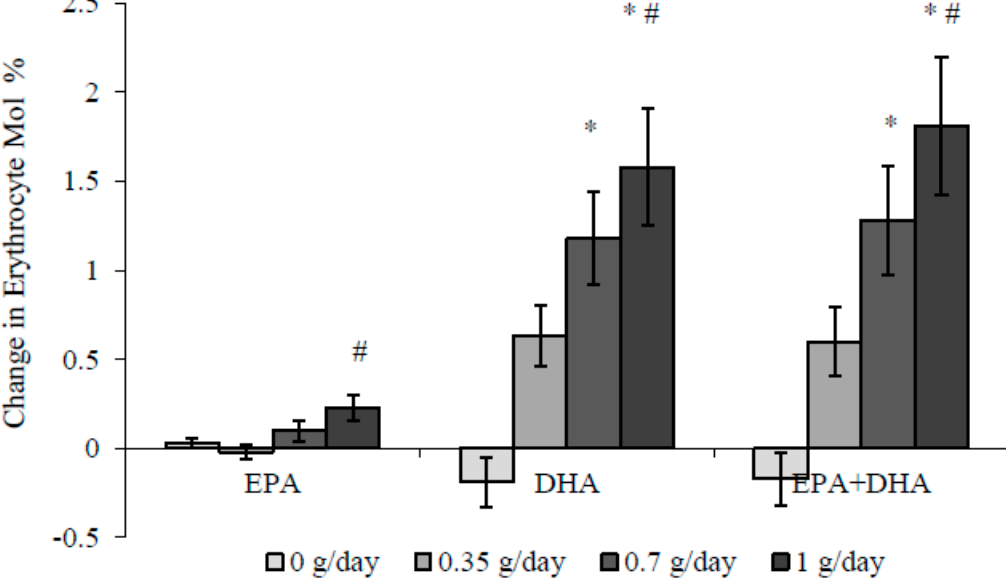
Figure 2. Changes in erythrocyte n -3 LCPUFA levels (mean ± SEM) following supplementation with 0–1 g/day n -3 LCPUFA from HiDHA™ tuna oil. * Significantly greater than 0 g/day using analysis of covariance (ANCOVA) ( p < 0.05), # Significantly greater than 0.35 g/day using ANCOVA ( p < 0.05). 0 g/day group n = 12; 0.35 g/day group n = 15; 0.7 g/day group n = 13; 1.0 g/day group n = 13. DHA: docosahexaenoic acid, EPA: eicosapentaenoic acid. Table 2. Plasma triglyceride and cholesterol levels (mmol/L) before and after supplementation with